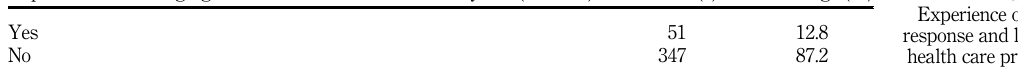
Table 3. Experience of GBV